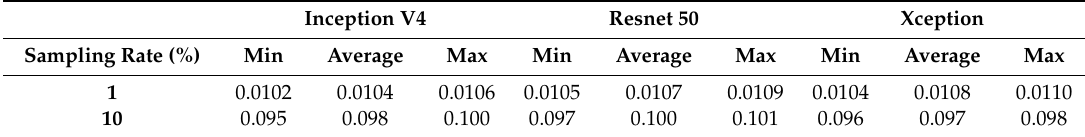
Table 2. E ff ect of sampling rate on scaled completion